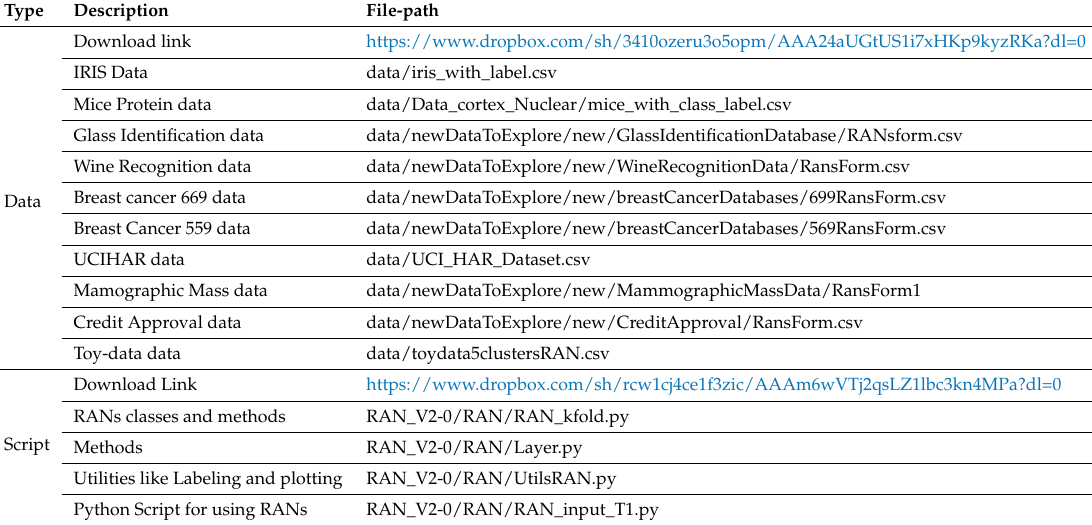
Table A1. Data and Python Script of RANs